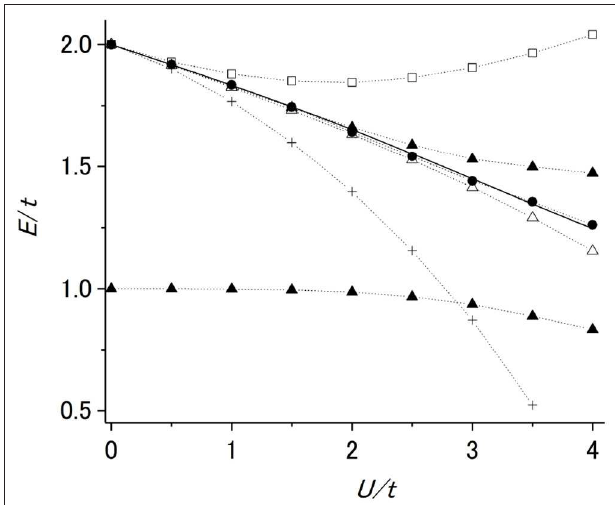
FIGURE 7 | Excitation energy of the spin mode with momentum transfer q π/ 3 as a function of U / t calculated in ERPA (dots). The results in RPA, = rRPA, SCRPA, and SRPA are denoted with the open triangles, filled triangles, squares and crosses, respectively. The exact solutions are depicted with the solid line. Adapted from Tohyama [ 33] under the Creative Commons CCBY license.